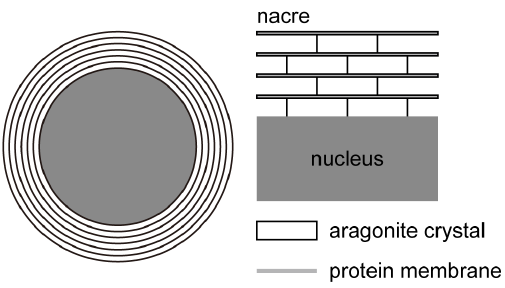
Figure 1. Schematic diagram of internal structure of cultured pearl. The translucent nacre surrounds the nucleus. The nacre comprises hundreds to thousands of nacreous layers. The thickness of each layer is approximately 300–500 nm.